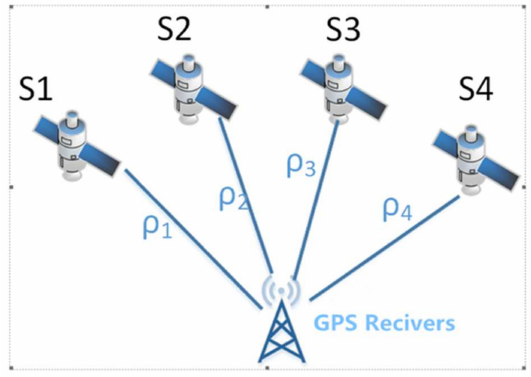
Figure 2. GPS single-point positioning